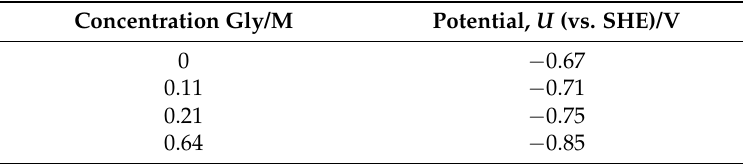
Figure 2. Cyclic voltammograms of the cathodic Fe-P deposition depending on the glycine concentration at 20 °C. ( a ) Glycine free; ( b ) 0.11 M Gly; and ( c ) 0.64 M Gly.